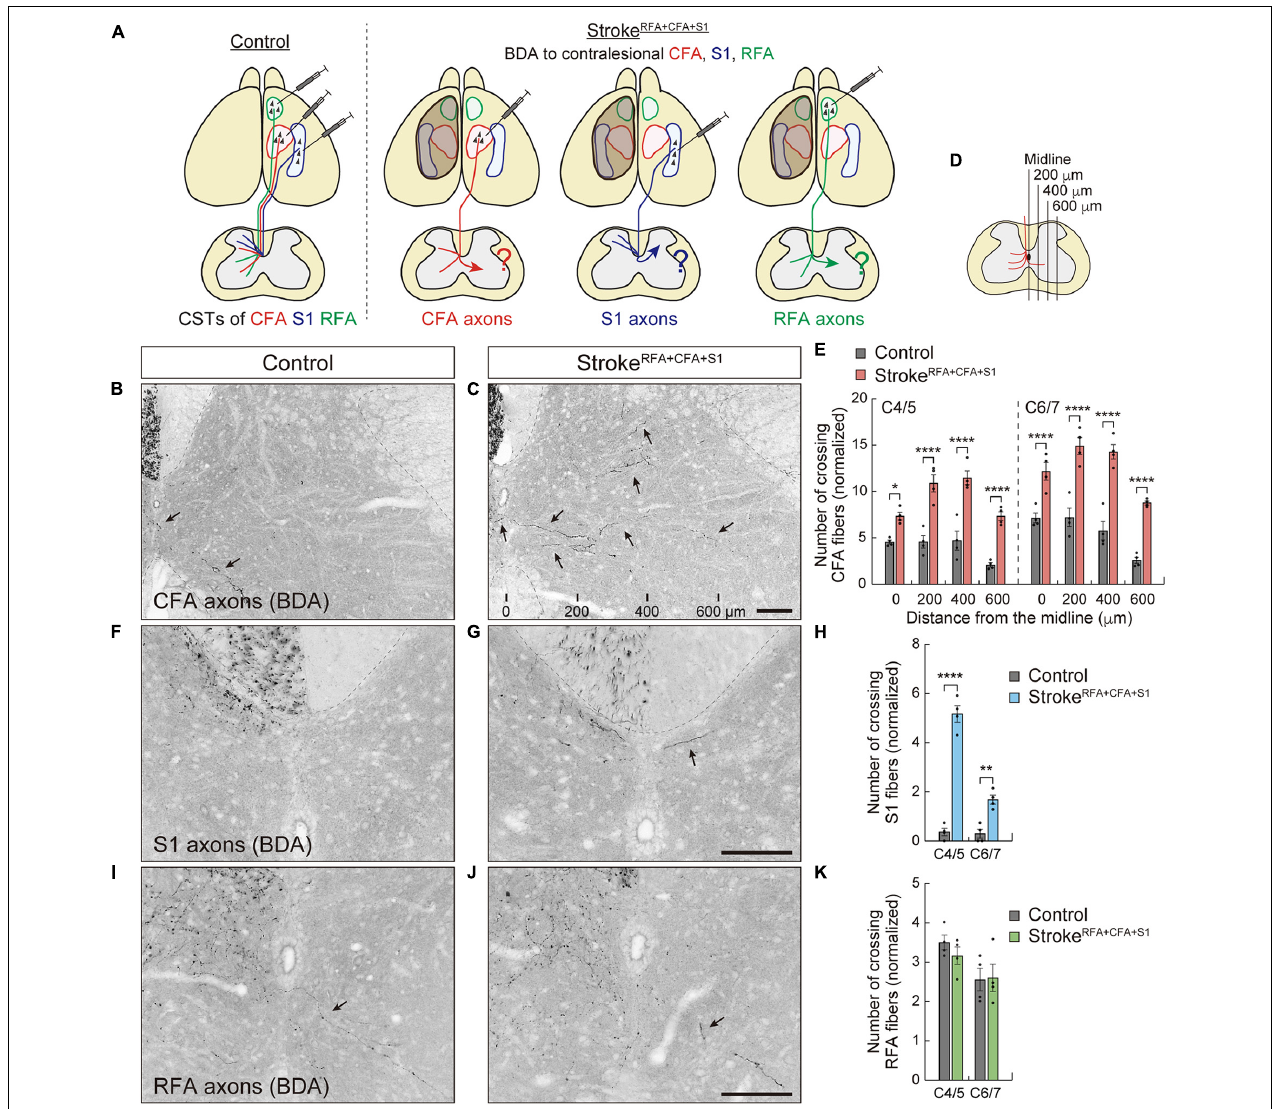
FIGURE 2 | Contralesional CST axons are rewired after a large cortical stroke in RFA, CFA, and S1. (A) Experimental diagram of anterograde labeling of CSTs from the contralesional CFA, RFA, and S1 in stroke RFA + CFA + S 1 . (B,C) Representative images of BDA-labeled CST axons of CFA in the cervical spinal cord (C5 level) of control (B) and stroke RFA + CFA + S 1 animals (C) . Arrows indicate the crossing fibers projecting to the denervated side. The distances from the midline are indicated at the bottom (C) . (D,E) The number of crossing fibers of CFA across the indicated lateral positions in the denervated side of C4–7. F ( 1 , 48 ) = 290.3, p < 0.0001, two-way ANOVA; p = 0.0485 (midline at C4/5), p < 0.0001 (others), Bonferroni post hoc test. (F,G) Representative images of BDA-labeled CST axons of S1 in the cervical spinal cord (C5) of control (F) and stroke RFA + CFA + S 1 animals (G) . (H) The number of crossing fibers of S1 at the midline of C4–7. F ( 1 , 12 ) = 188.3, p < 0.0001, two-way ANOVA; p < 0.0001 (C4/5), p = 0.0019 (C6/7), Bonferroni post hoc test. (I,J) Representative images of BDA-labeled CST axons of RFA in the cervical spinal cord (C5) of control (I) and stroke RFA + CFA + S 1 animals (J) . (K) The number of crossing fibers of RFA at the midline of C4–7. F ( 1 , 12 ) = 0.2983, p = 0.5950, two-way ANOVA; p = 0.7827 (C4/5), p > 0.9999 (C6/7), Bonferroni post hoc test. * p < 0.05, ** p < 0.01, **** p < 0.0001, n = 4. Scale bars, 100 µ m.